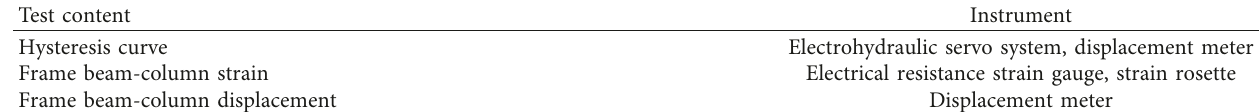
Table 2: Main content of the measurements and the selection of instruments.